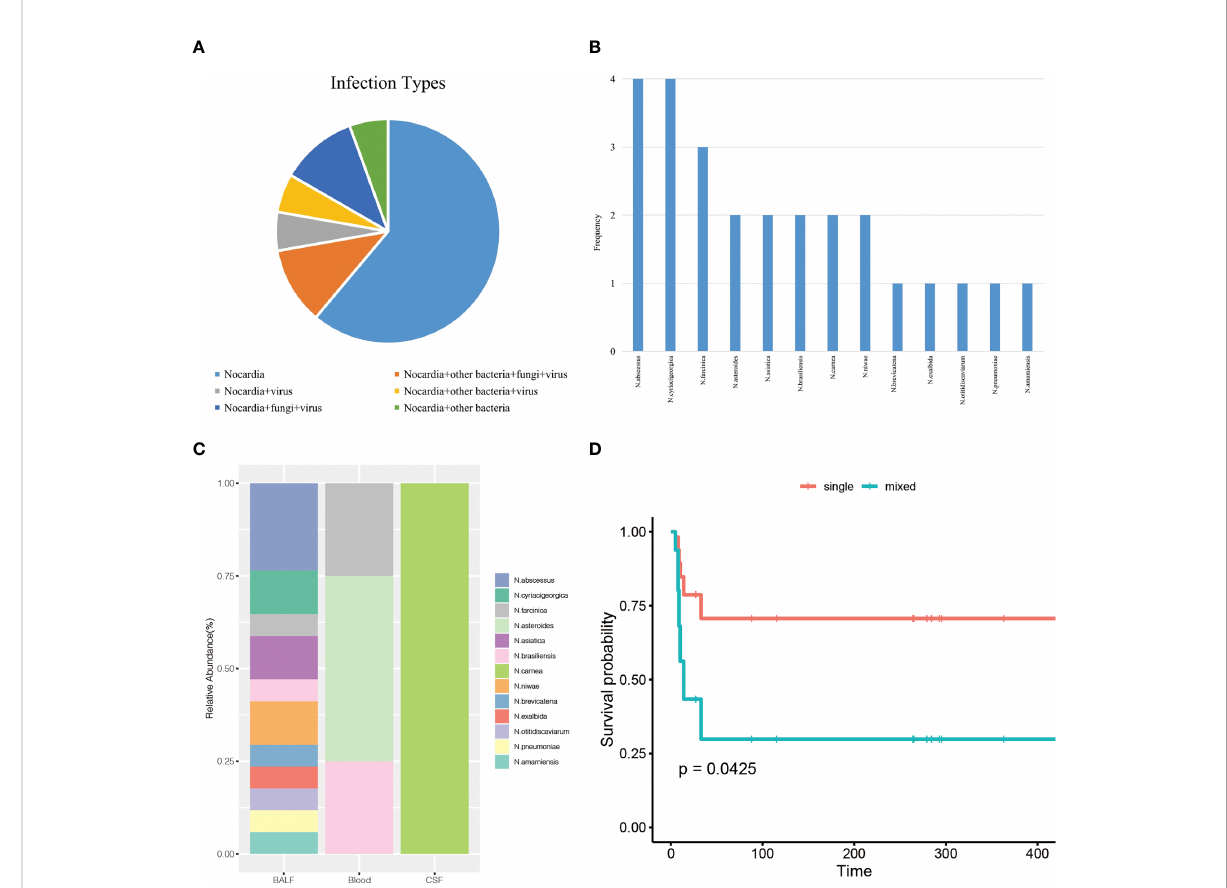
FIGURE 1 (A) , infection types of the patients. (B) , the frequency of the 13 Nocardia species detected by mNGS. (C) , the distribution of Nocardia species in BALF, blood, and CSF samples. (D) , overall survival analysis for nocardiosis patients according to infection